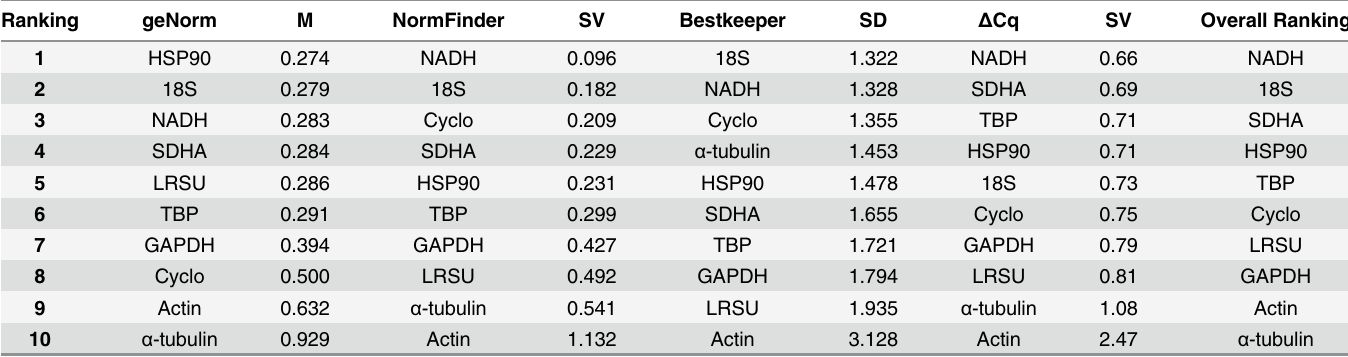
Expression stability assessment analysis by Δ Cq In addition to the above programs, a standard Δ Cq analysis was carried out [44]. This method does not take into account the different efficiencies of reaction primer sets but gives a useful raw measure of stability and yielded similar results to the more complex algorithms with NADH ranked as the most stable reference gene analysed (Table 2). Table 2. Ranking of candidate reference genes.